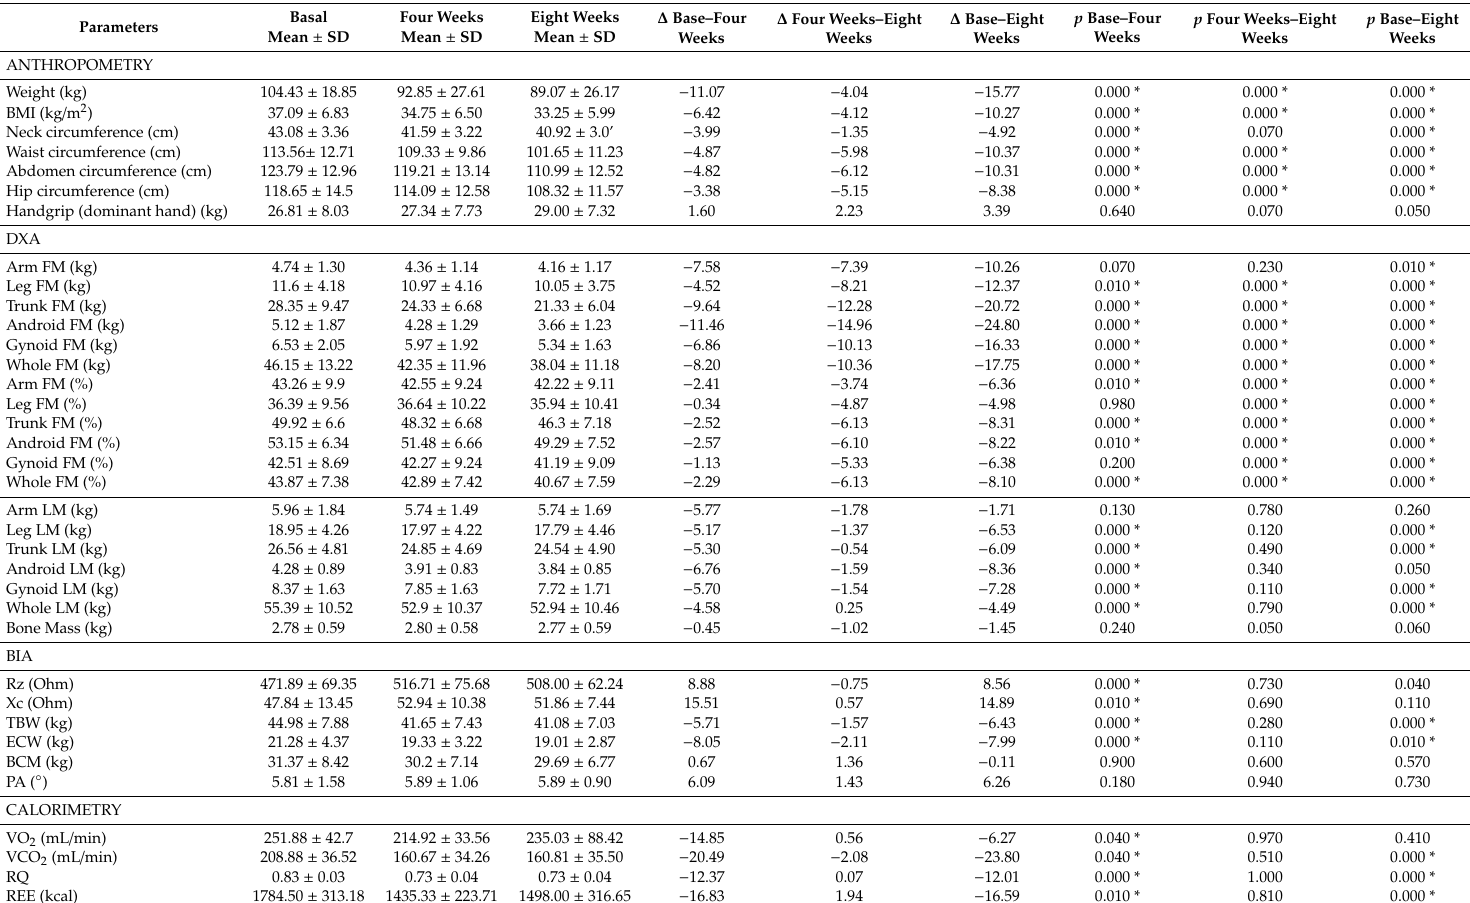
Table 2. Parameter changes during dietetic treatment (baseline, four weeks, eight